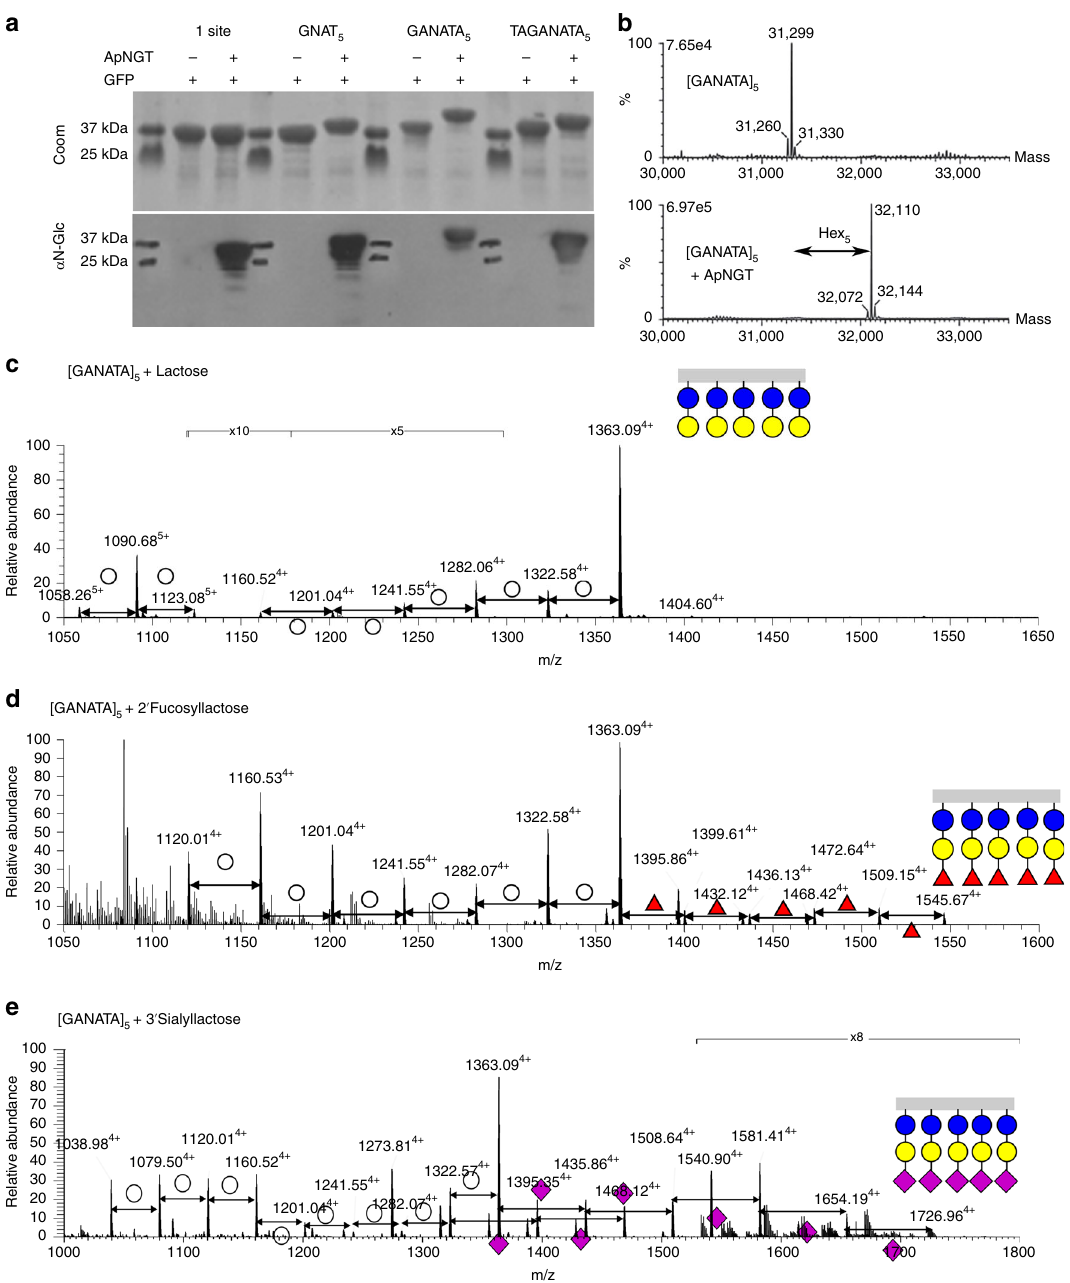
Fig. 2 Multivalent glycopolymers. a Substrate proteins bearing a variety of pentavalent glycotags were co-expressed with and without the NGT, af fi nity puri fi ed, and analyzed by denaturing PAGE followed by Coomassie staining or immunoblot using an N-Glc-reactive serum. b Intact protein mass spectra of GFP-[GANATA] 5 expressed alone (upper panel) or with ApNGT from a p15A replicon plasmid (lower panel), showing uniform modi fi cation with fi ve N-linked glucose residues. c – e Peptide LC – MS spectra show the glycosylation pro fi le of the GFP-[GANATA] 5 substrate protein following co-expression with the established pathways for c lactose, d 2 ′ -fucosyllactose, and e 3 ′ -sialyllactose. The assigned structures are supported by HCD – MS/MS spectra (Supplementary Fig. 8). Blue, yellow, and white circles represent glucose, galactose, and hexose, respectively. Red triangles and purple diamonds indicate fucose and sialic acid, respectively. Source data are provided as a Source Data fi